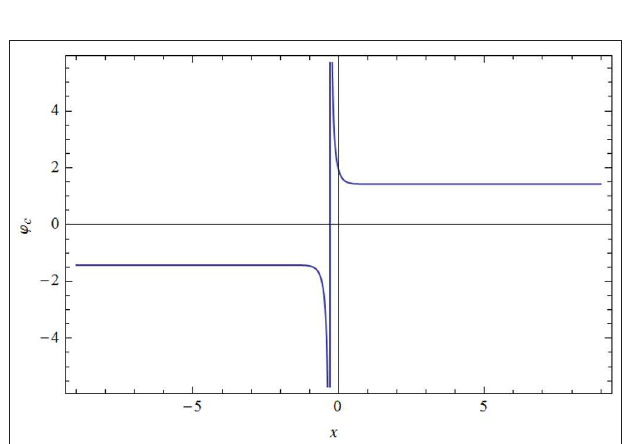
FIGURE 5 | Variation of explosive shock φ c against χ for β v 0.5, L = =